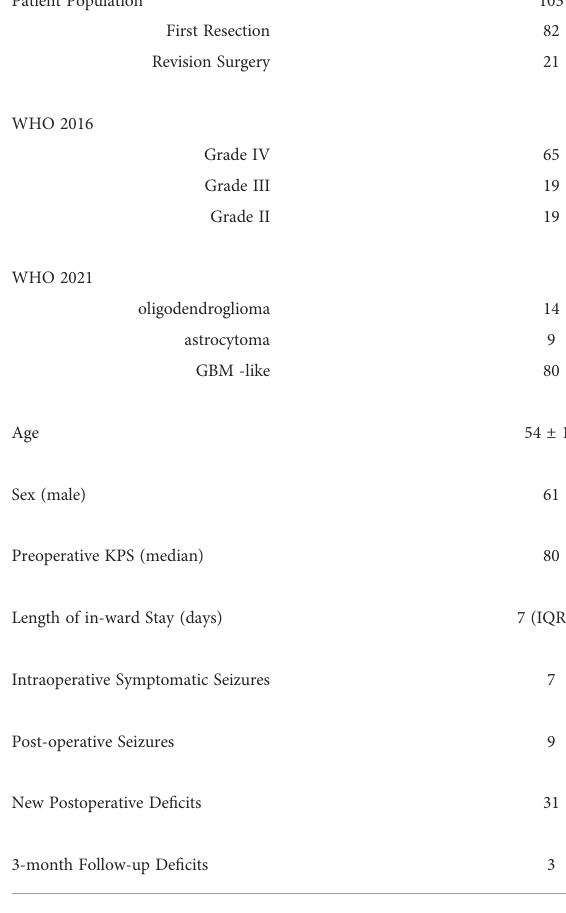
TABLE 2 Clinical and histological features of our